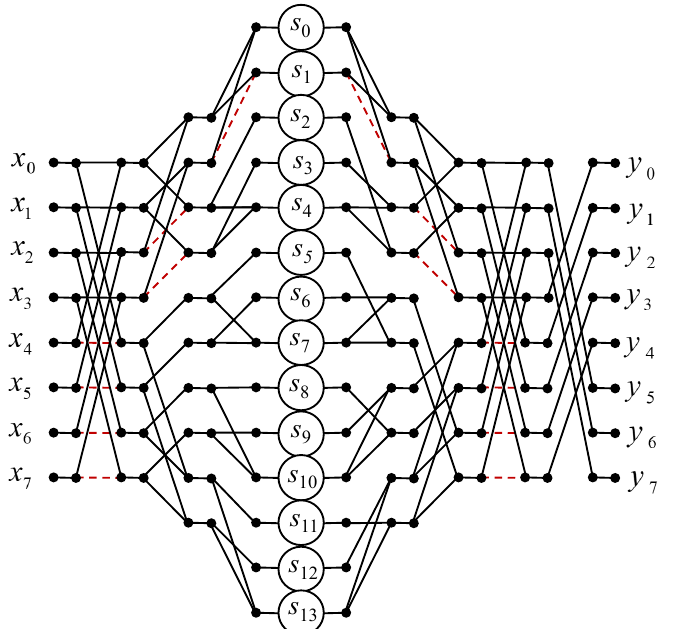
Figure 7. Algorithmic structure of the processing core for the computation of the 8-point circular